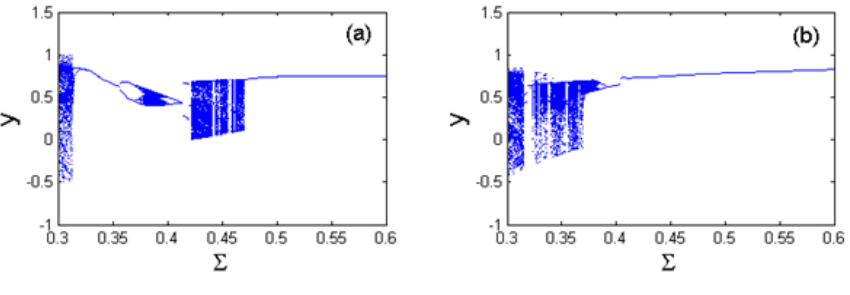
Figure 11. Bifurcation diagram of th 1 cm e material property parameter Σ at different cubic stiffness ratios: (a) β = 0.3; (b) β =